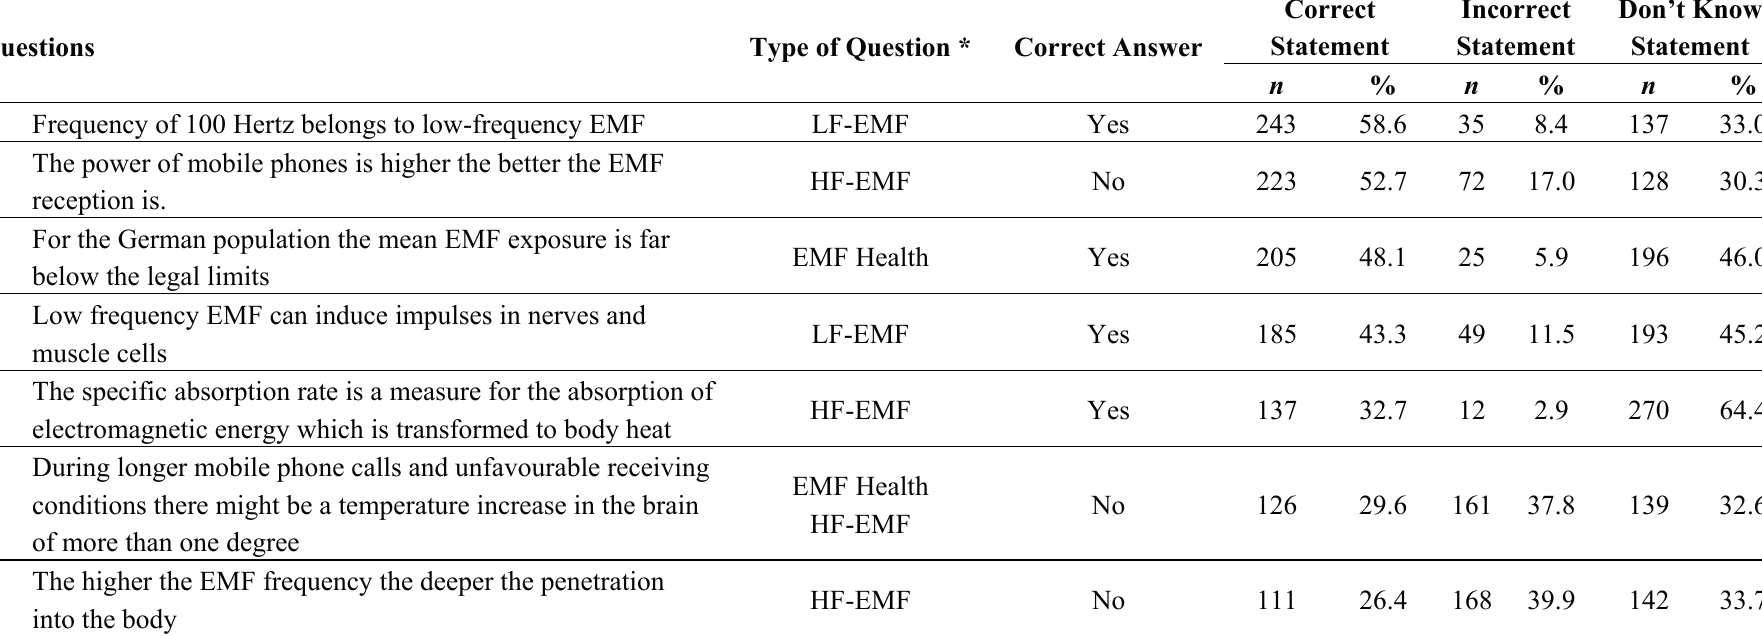
Table 1. Answers to questions about EMF-knowledge by GPs in Germany in